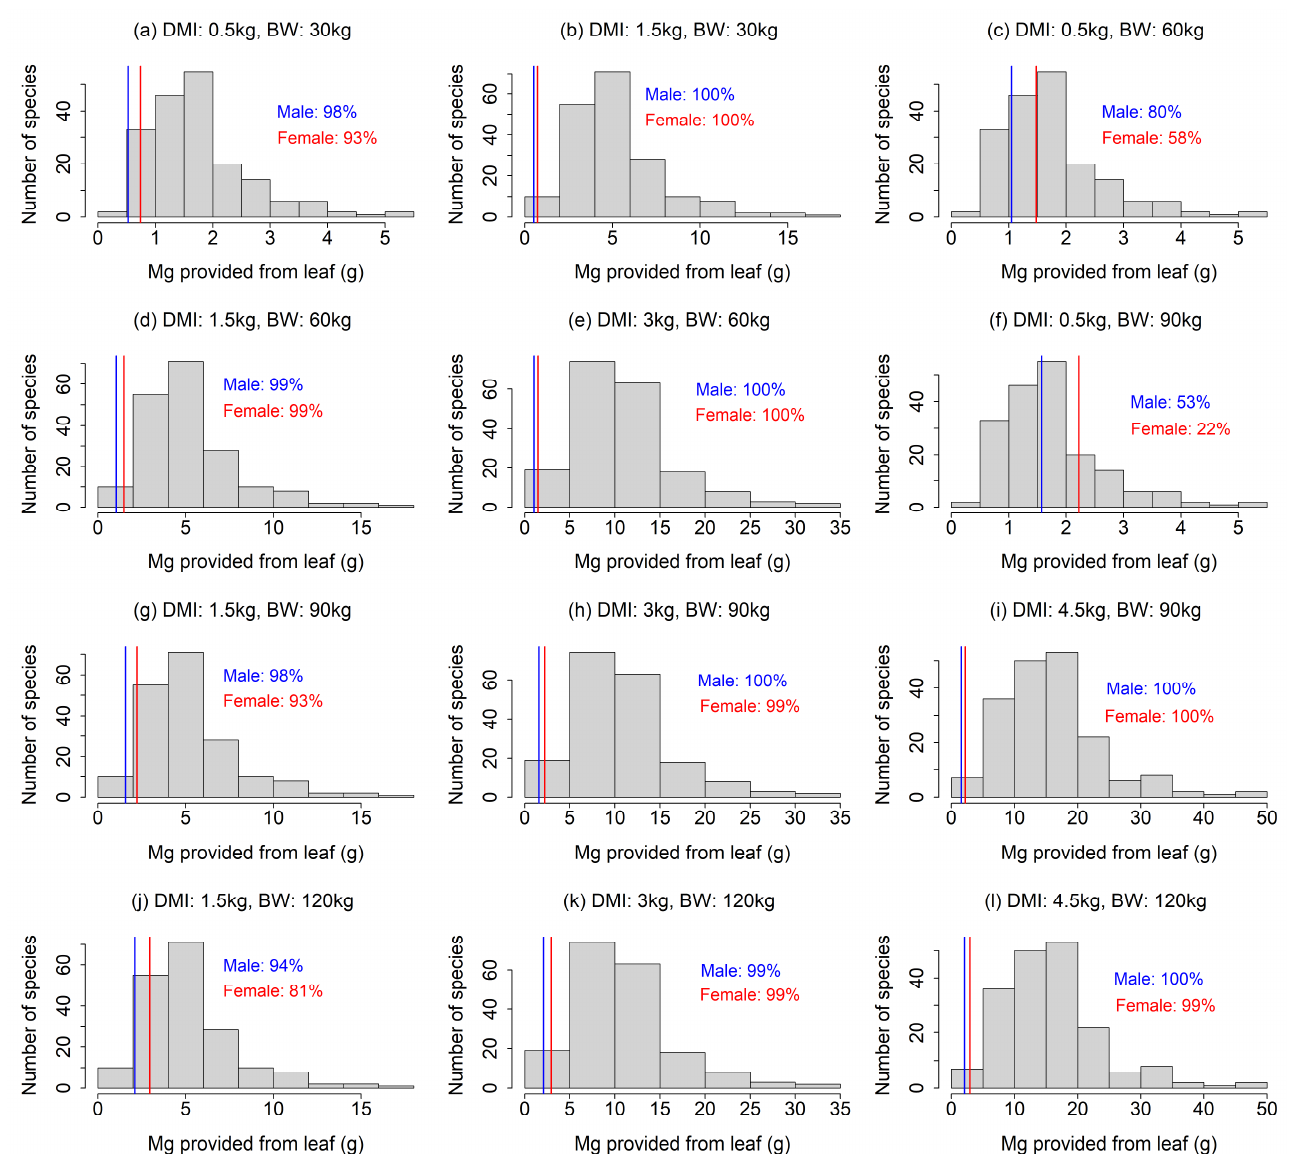
Figure 3. ( a – l ) Comparison of Mg provision by feed plants and the Mg requirement of sika deer under 12 scenarios (four dry matter intake levels × four body weights, excluding unrealistic scenarios). The histogram indicates the distribution of Mg provision calculated from the leaves of feed plant species. The solid lines indicate the Mg requirements of male (blue) and female (red) sika deer. Mg requirement of females during the non-lactating period is equal to the Mg requirement of males. In the figures, the percentage is the proportion of feed plant species that meet the Mg requirements.